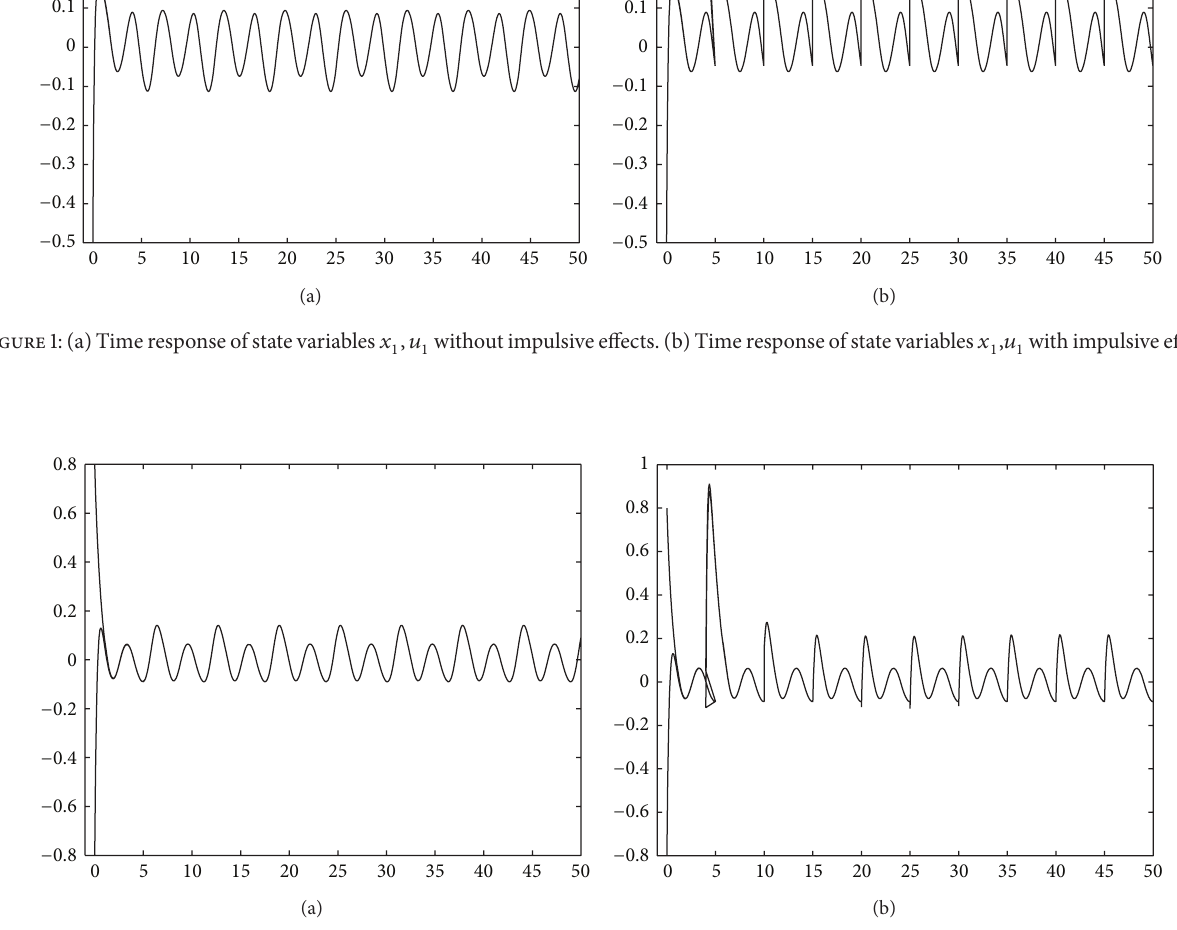
Figure 2: (a) Time response of state variables 𝑥 2 , 𝑢 2 without impulsive effects. (b) Time response of state variables 𝑥 2 , 𝑢 2 with impulsive